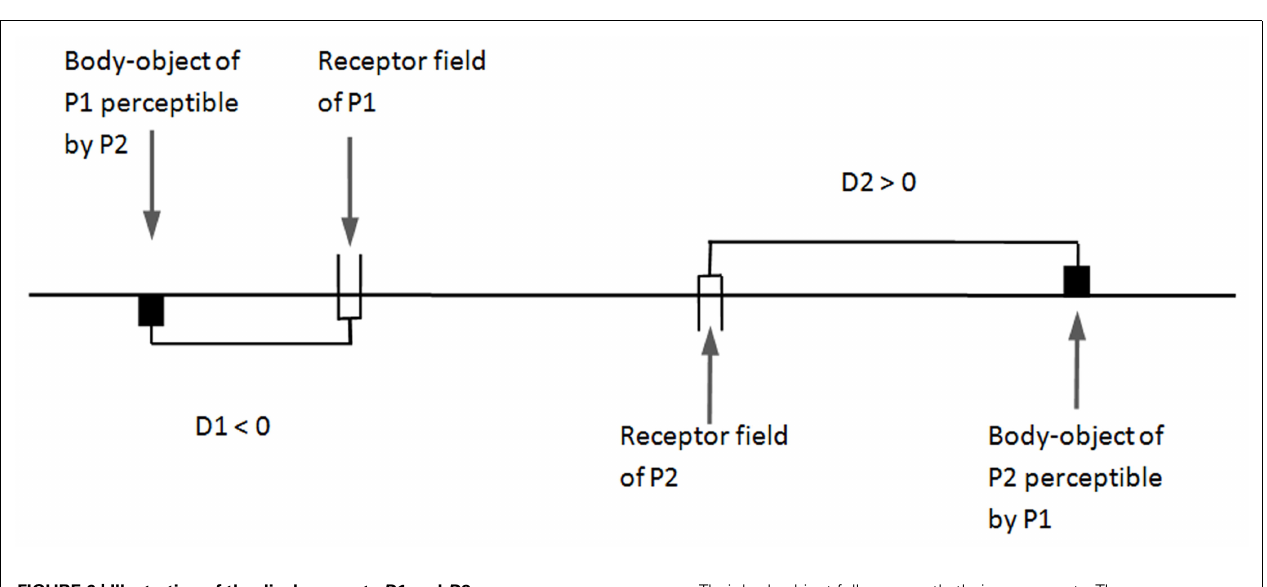
FIGURE 6 | Illustration of the displacements D 1 and D 2 between receptor field and body-object – experiment 3. The subjects freely move their receptor field in this one-dimensional